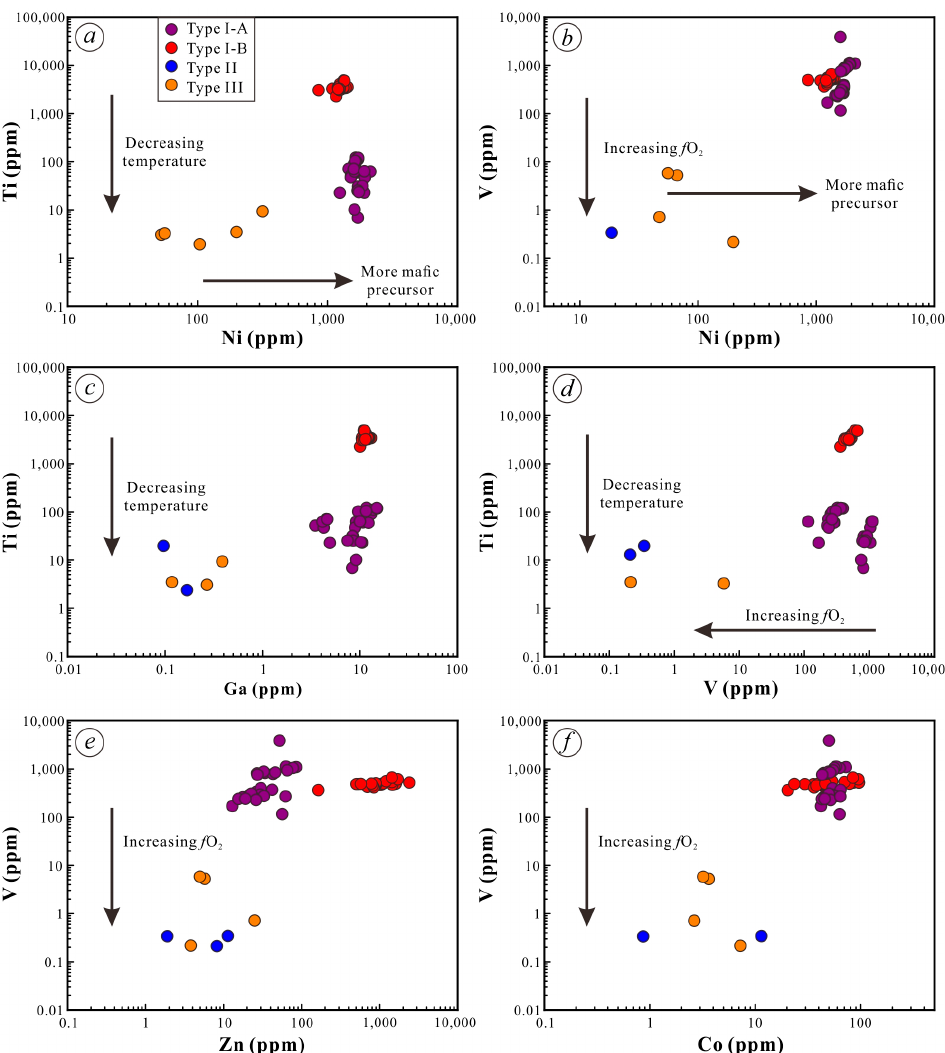
Figure 7. Binary diagrams of ( a ) Ti vs. Ni, ( b ) V vs. Ni, ( c ) Ti vs. Ga, ( d ) Ti vs. V, ( e ) V vs. Zn, and ( f ) V vs. Co for the Jinchuan different types of magnetite in massive and disseminated sulfide ores. Note that the limited data for Type II and III magnetite in this figure is same as Figure 6.